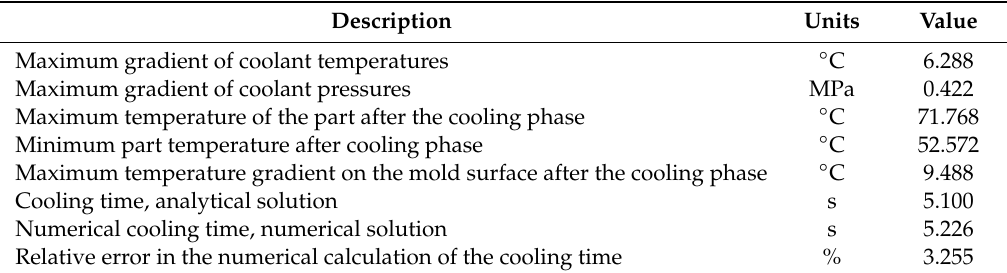
Table 11. Numerical results obtained for Case C cooling analysis.